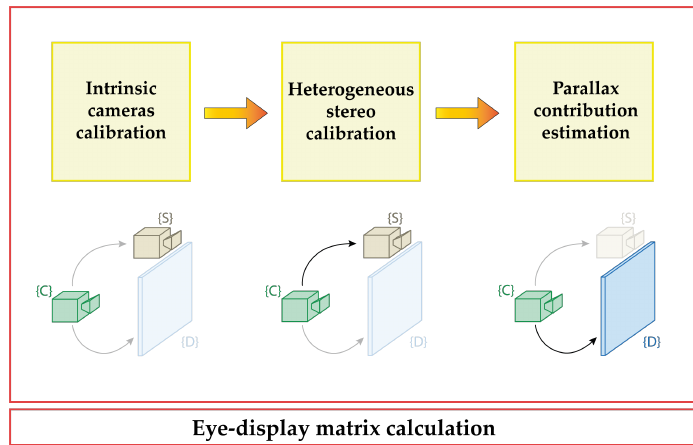
Figure 7. Conceptual schematic of the optical see-through display calibration